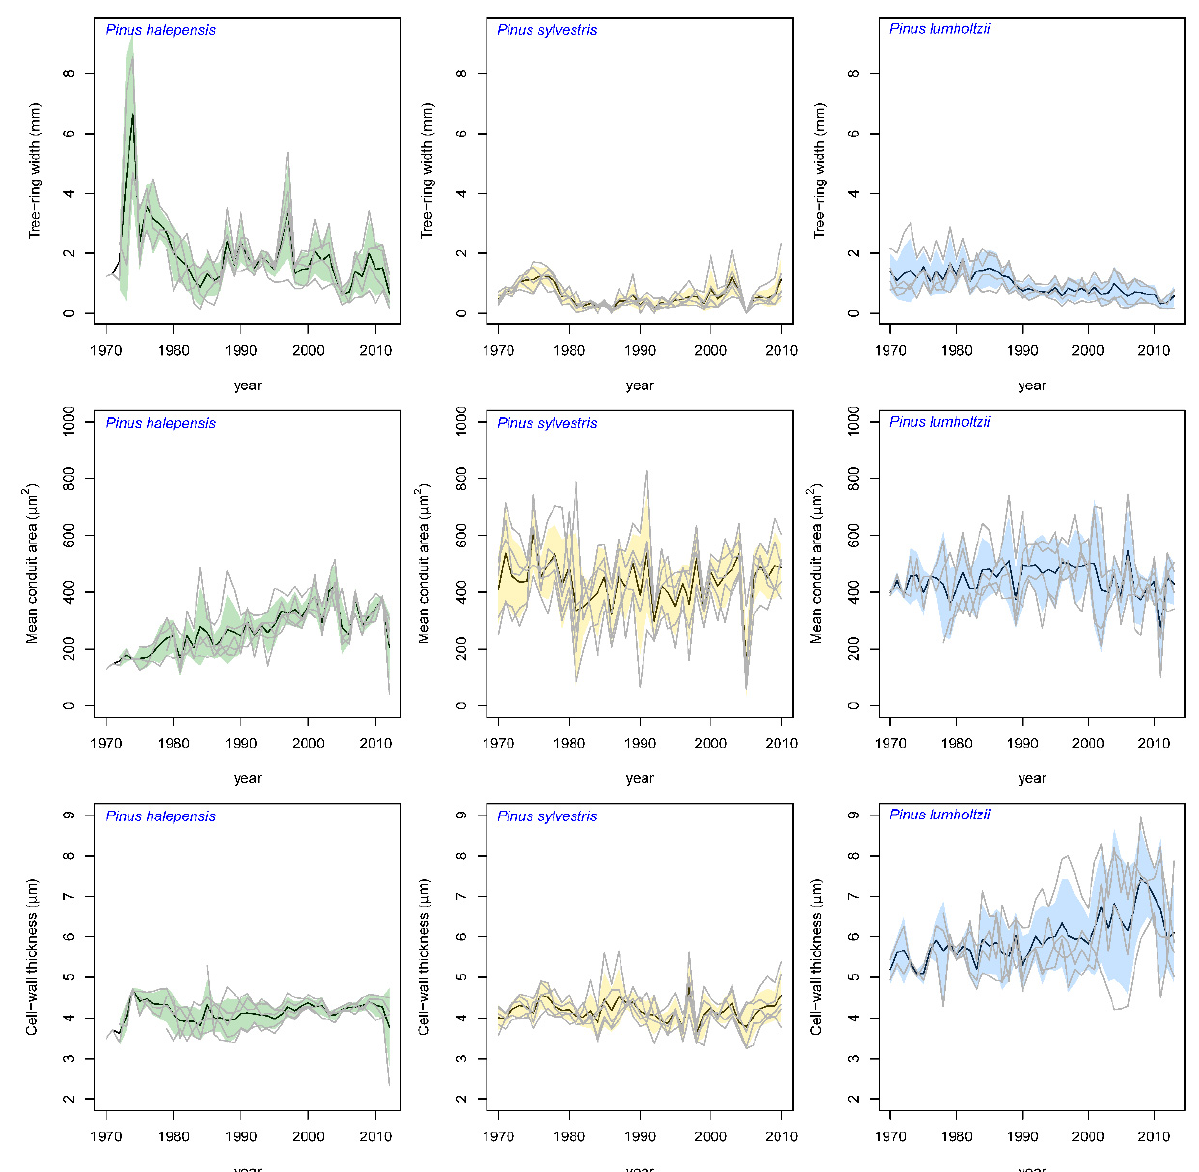
Figure 3. Average series (black line) of each variable and species and individual series (grey lines) along with the standard deviation of the mean (shaded areas). along with the standard deviation of the mean (shaded